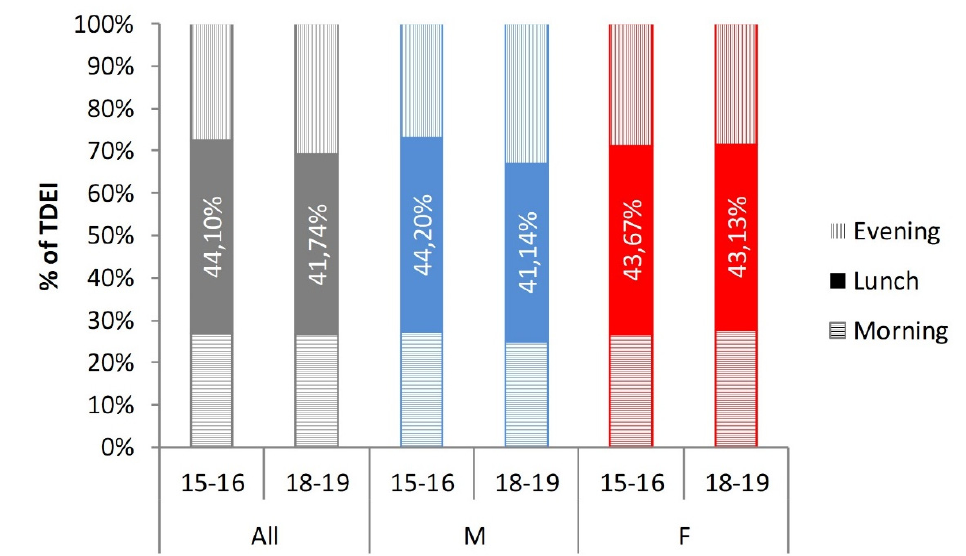
Figure 1. Morning, lunch, and evening energy intake contribution to total daily energy intake (TDEI) shown as a percentage of TDEI depending on age and gender of adolescents. The whole population is marked in grey, male population in blue and female population in red color.